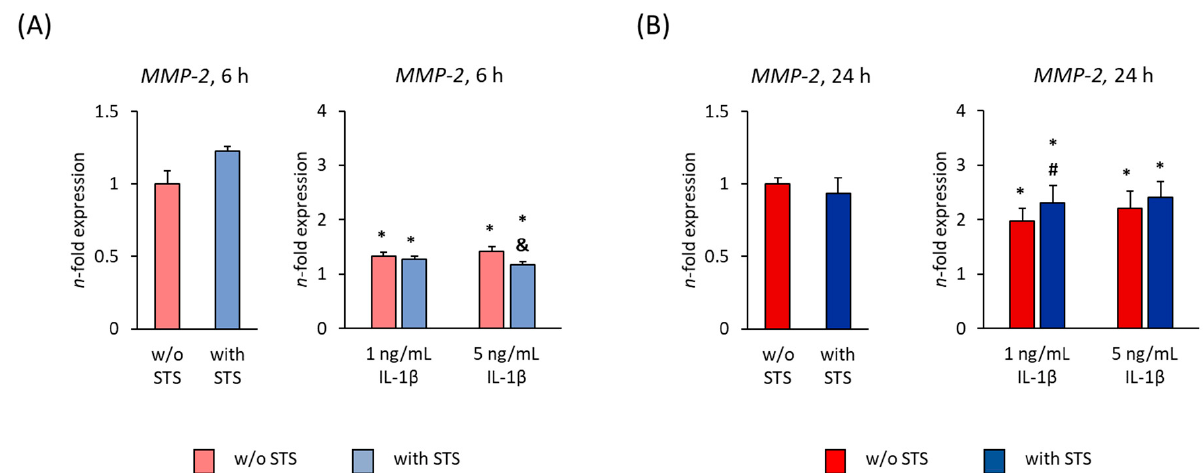
Figure 4. Effect of static orthodontic tensile forces on the IL-1 β -induced gene expression of MMP-2 in hPDL-MSCs in the absence of FBS. STS with 6% equibiaxial elongation was applied to untreated or IL-1 β -treated hPDL-MSCs in the absence of FBS. 6 ( A ) and 24 ( B ) hours after stimulation with or without STS, qPCR was performed showing the n -fold expression levels of MMP-2 compared to the appropriate controls ( n -fold expression = 1). GAPDH served as an en- dogenous control. All data are presented as mean ± S.E.M. * p -value ≤ 0.05 significantly higher compared to the ap- propriate control; # p -value ≤ 0.05 significantly higher compared to the appropriate IL-1 β stimulated cells without STS; & p -value ≤ 0.05 significantly lower compared to the appropriate Il-1 β stimulated cells without STS.